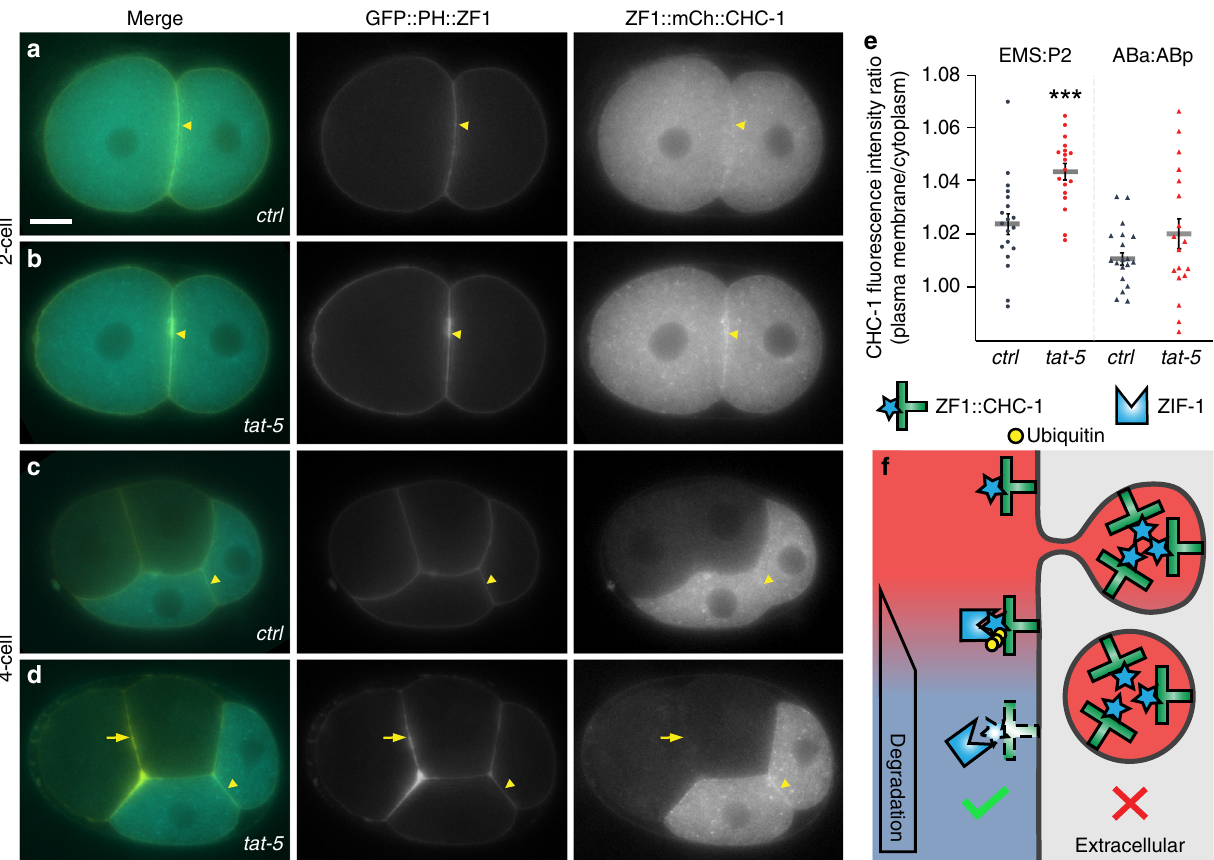
Fig. 4 Degron protection assay reveals protein topology. a A degron-tagged clathrin reporter ZF1::mCh::CHC-1 initially localizes to the plasma membrane (arrowhead) and intracellular puncta ( n = 9). Scale bar: 10 µ m. b After tat-5 knockdown, ZF1::mCh::CHC-1 is enriched at the plasma membrane (arrowhead, n = 14). c After expression of ZIF-1 begins in anterior cells, ZF1::mCh::CHC-1 is degraded throughout the anterior cells in control embryos ( n = 19). d Although ZF1::mCh::CHC-1 is still enriched at the plasma membrane in posterior cells (arrowhead) in tat-5 RNAi-treated embryos, ZF1::mCh::CHC-1 is lost from the plasma membrane in anterior cells (arrow, n = 18), indicating that clathrin is accessible to ubiquitin ligases. GFP::PH::ZF1 labels the plasma membrane and extracellular vesicles. e Quanti fi cation of clathrin enrichment on a posterior cell contact (EMS:P2) or anterior cell contact (ABa:ABp) compared to the neighbouring cytoplasm at the four- and six-cell stage from two independent experiments. ZF1::mCh::CHC-1 fl uorescence was signi fi cantly increased at the posterior EMS:P2 cell contact (*** p < 0.001 using Student ’ s t -test, ctrl n = 19, tat-5 RNAi n = 18). No change was observed at anterior cell contacts ( p > 0.05). Bars represent mean ± s.e.m. Source data are provided as a Source Data fi le. f If clathrin were in extracellular vesicles, ZF1::mCh::CHC-1 would be protected from ZIF-1-mediated degradation. However, as clathrin is inside the plasma membrane, ZF1::mCh::CHC-1 is accessible to